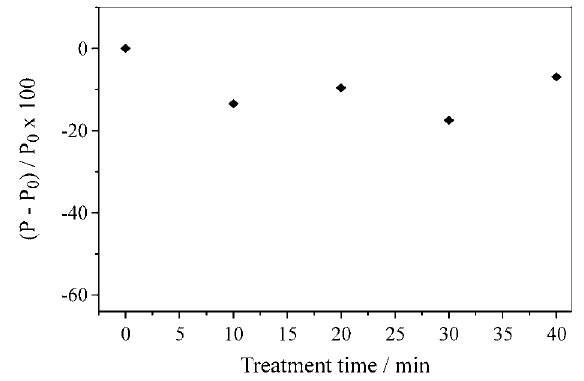
Figure 6. Nitrogen percentual variation permeability through ultrafiltra- tion PSf membranes after argon plasma treatment, at 10 W.